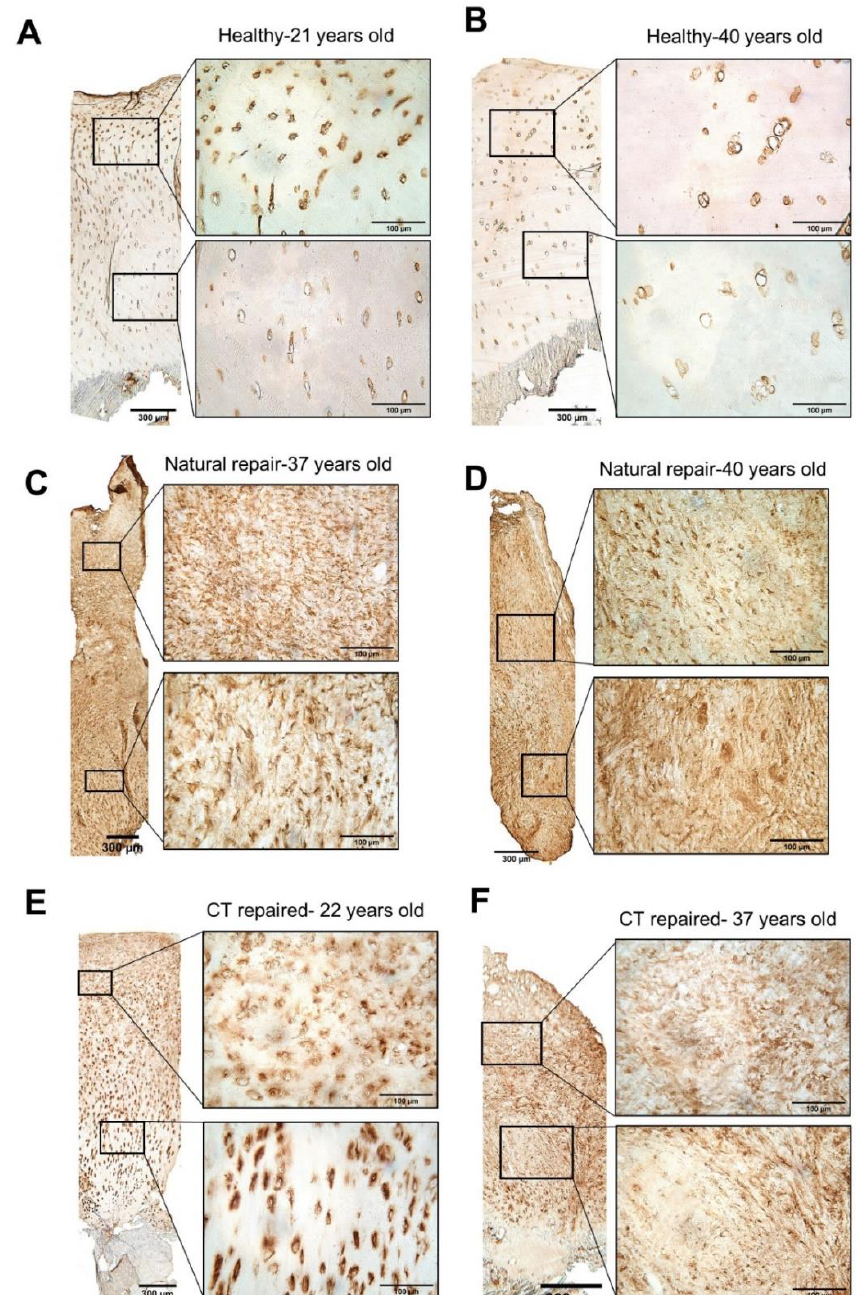
Figure 2. Immunohistochemistry of perlecan. Monoclonal antibodies (A74) were used to detect the presence of perlecan in cryosections of core biopsies. ( A , B ) Heathy cartilage ( n = 5) from cadavers all showed distinct pericellular staining for perlecan with a typically hyaline morphology. ( C , D ) Naturally repaired cartilage ( n = 10) from the harvest site of autologous cell therapy donors showed heterogenous staining patterns, some having both widespread matrix and pericellular staining (( C ), donor 10), whilst in others there was diffuse matrix staining throughout (( D ), donor 9). ( E , F ) Cell therapy repaired (CT, n = 9) cartilage also showed a heterogenous localisation for perlecan, similar to the naturally repaired tissues. The sample depicted in ( E ) (donor 2) shows pericellular staining for perlecan in repair tissue with hyaline cartilage morphology, but not as discretely as in the healthy tissues. The sample depicted in ( F ) (donor 7) shows predominantly matrix immunolocalisation of perlecan. Scale bars show 300 µ m for low magnification images and 100 µ m for high magnification inserts. Isotype controls found in Supplementary Figure